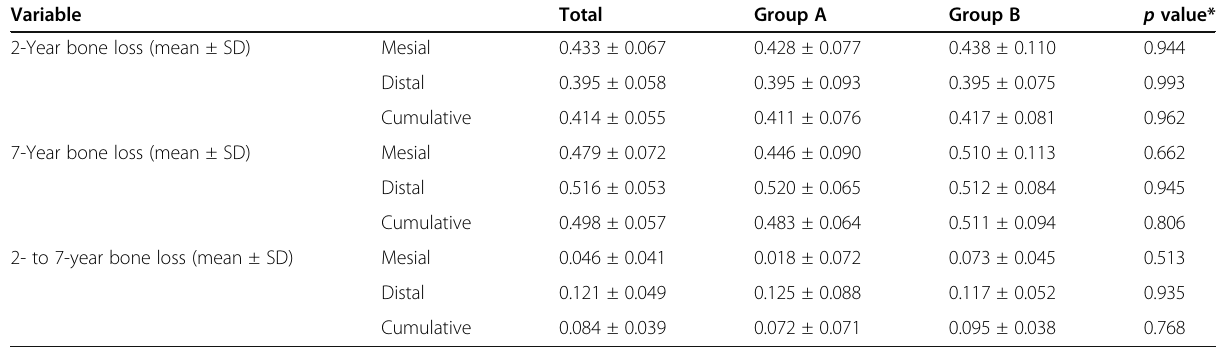
Table 6 Marginal bone loss on different follow-up times Variable